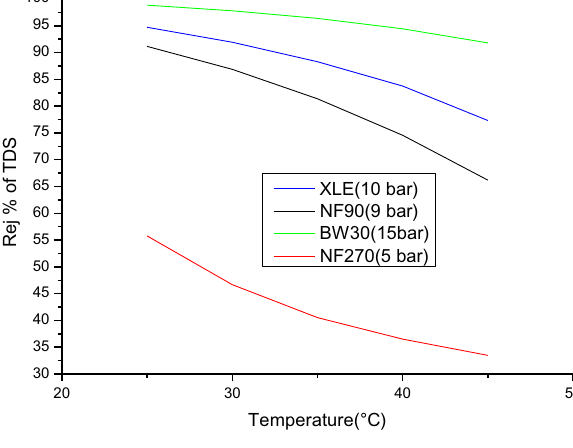
Fig.5 Effect of temperature on recovery ratio at optimum feed pres- sure for conf b